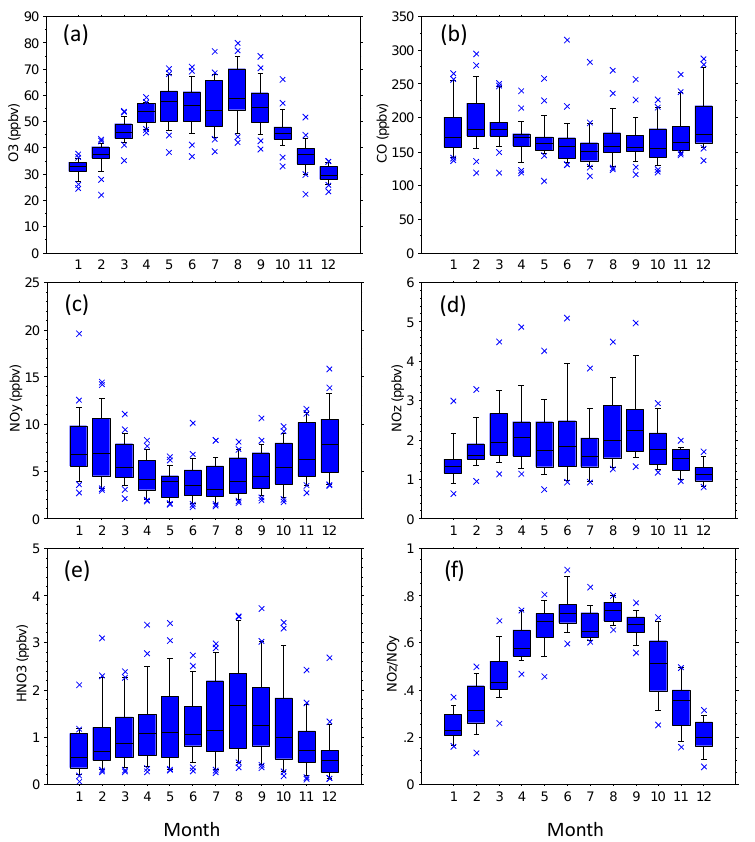
Figure 5. Statistical distributions of mean monthly species mixing ratios (all SEARCH sites, 1992–2014). Distributions indicate the 10th, 25th, 50th, 75th, and 90th percentiles of the monthly